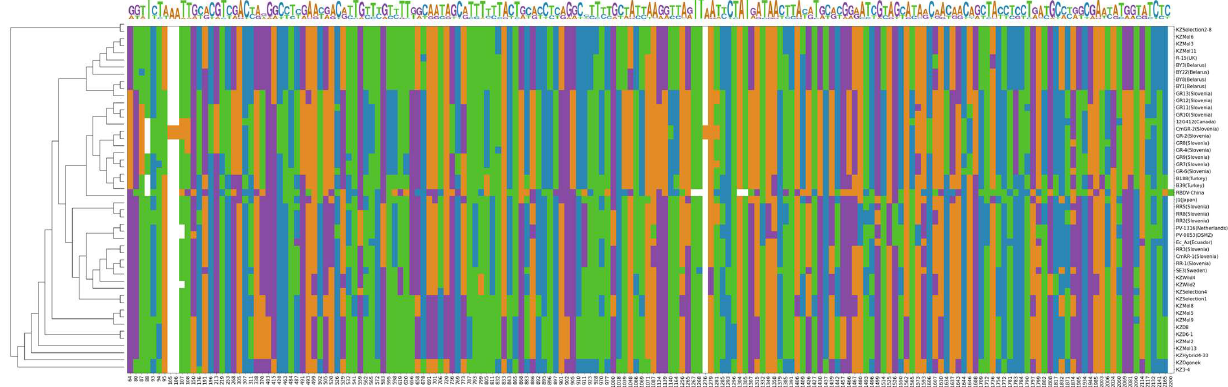
Figure 3. Heat map and logo of most variable regions within complete RBDV RNA2 sequences that were included in the phylogenetic tree.